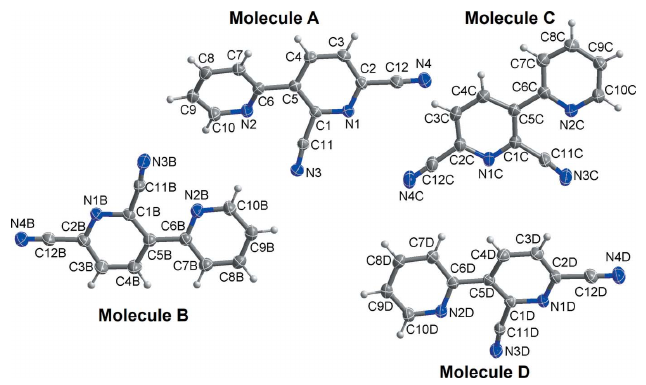
Figure 1 The molecular structure of the four independent molecules ( A , B , C and D ) of the title compound, with the atom-numbering scheme. Displace- ment ellipsoids are drawn at the 50% probability